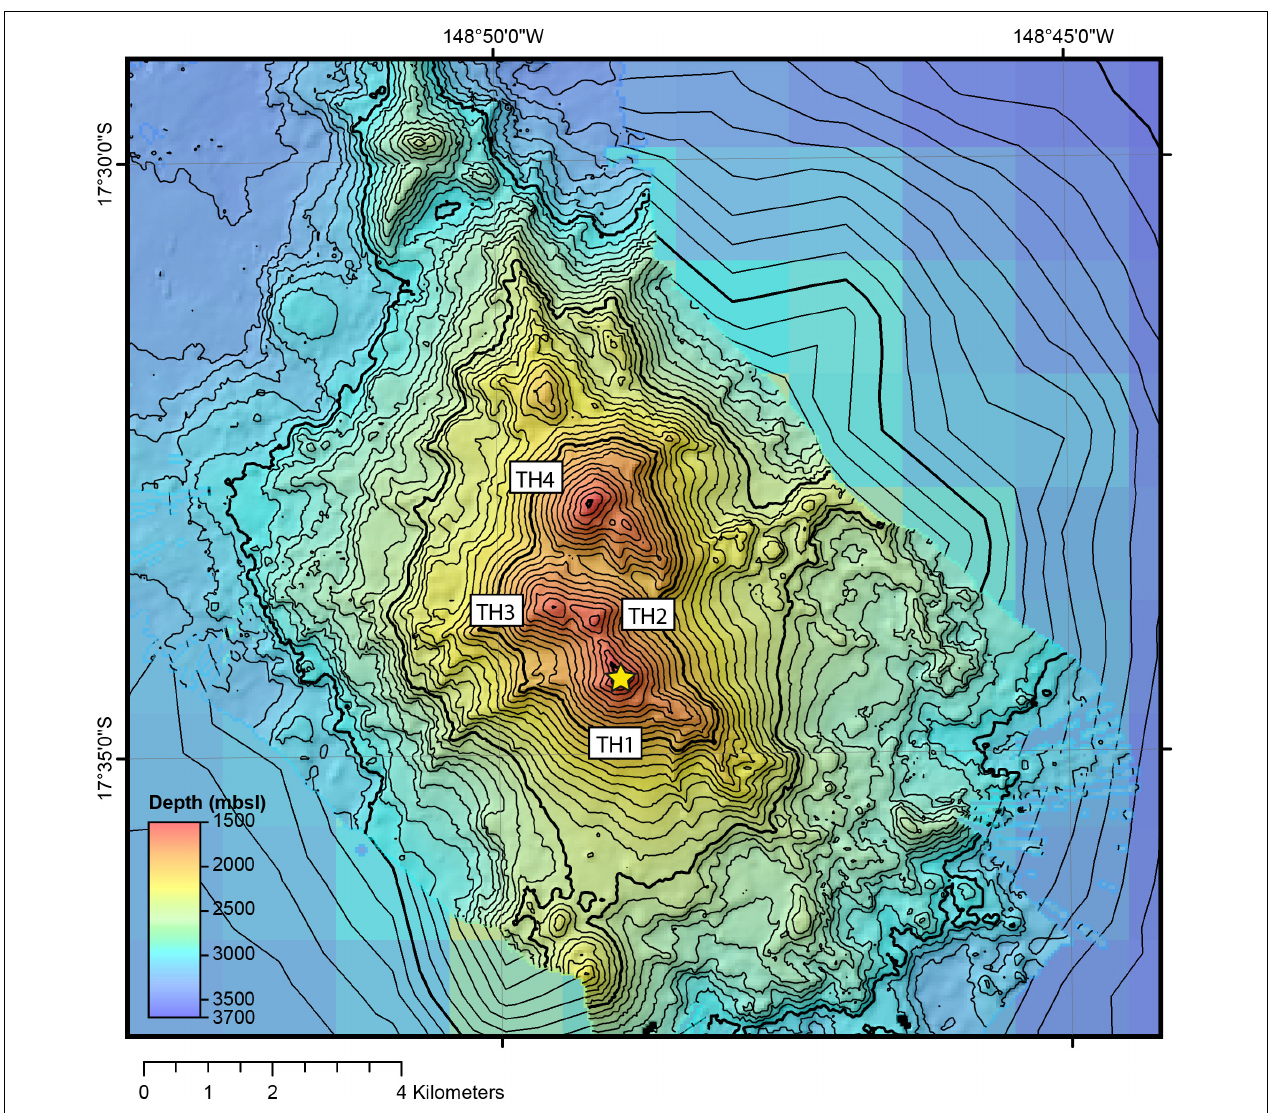
FIGURE 3 | Multibeam bathymetric plot of Teahitia Seamount as mapped during RV Thomas G. Thompson cruise TGT303 in December 2013. TH1-TH4 represent the four principle cones of this composite volcano. Yellow star shows the location of US GEOTRACES CTD Station GP16- 37 occupied directly above the TH1 cone at 17 ◦ 34.4 (cid:48) S, 148 ◦ 49.0 (cid:48) W using the ship’s dynamic positioning